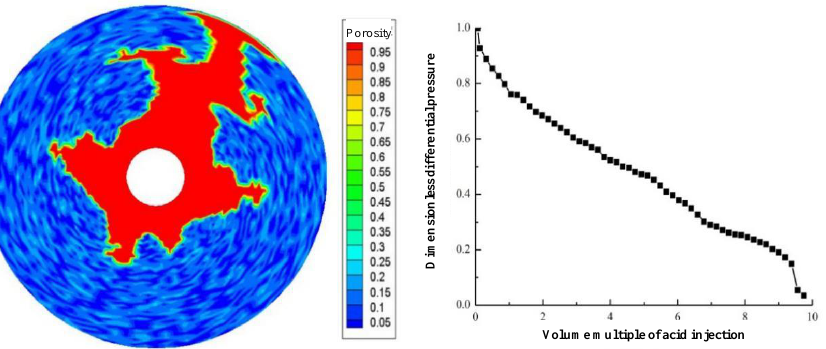
Figure 2. Change of dissolution form and differential pressure with gelling acid injection volume (gelling acid injection speed 0.0135 cm/min).